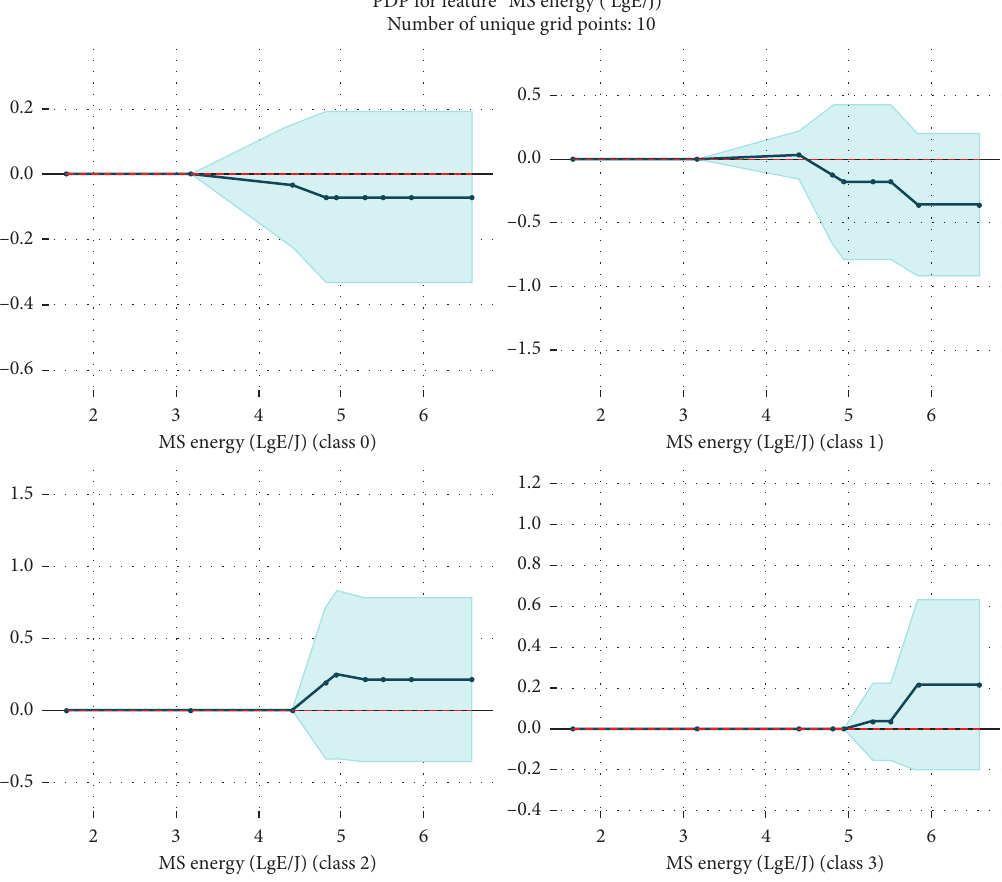
PDP for feature “MS energy ( LgE/J)” Number of unique grid points: 10